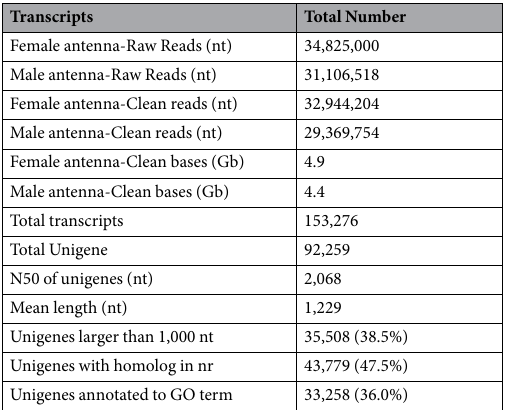
Table 1. Assembly summary of O . communa antennal transcriptome. nt = nucleotides, Gb =